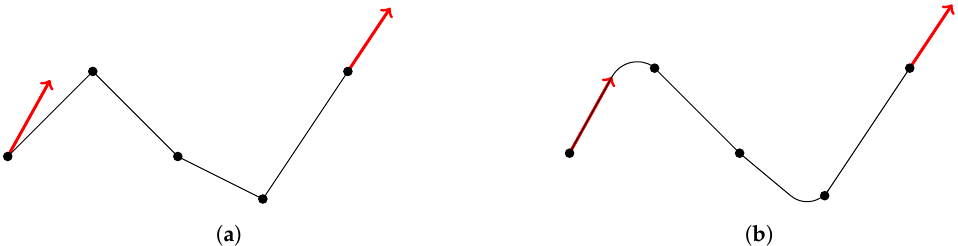
Figure 10. Path modification: The first path is computed by the FMT algorithm. The second path is the path after the addition of Dubins curves to respect the heading constraints (in red). ( a ) Path without Dubins curve; ( b ) Path with Dubins curve.